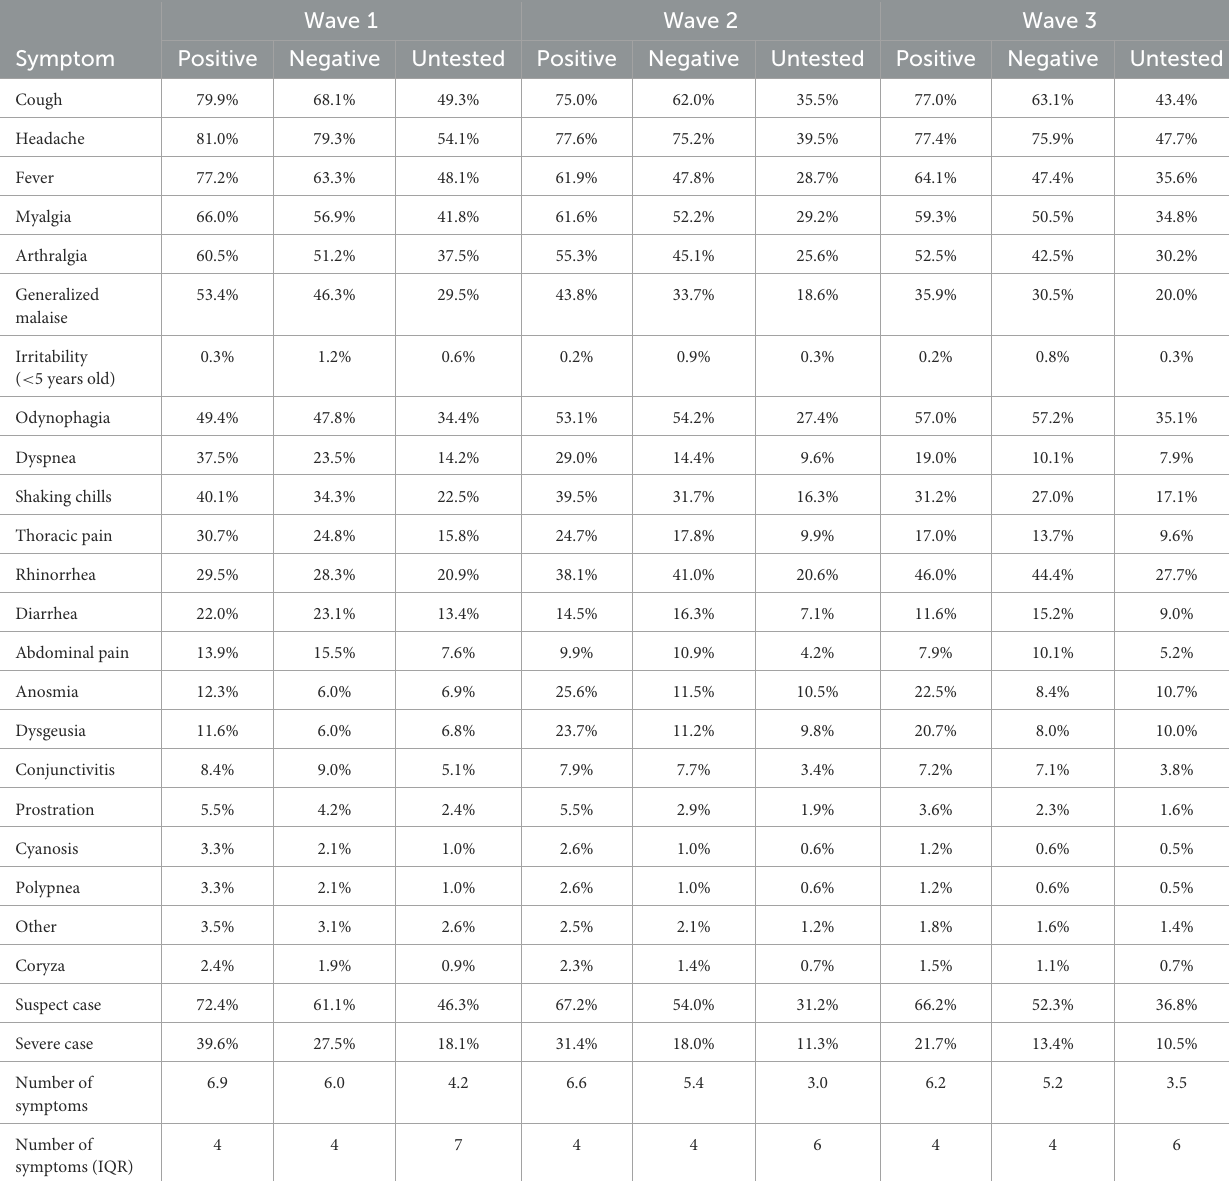
TABLE 3 Prevalence of symptoms among suspect cases by wave and testing